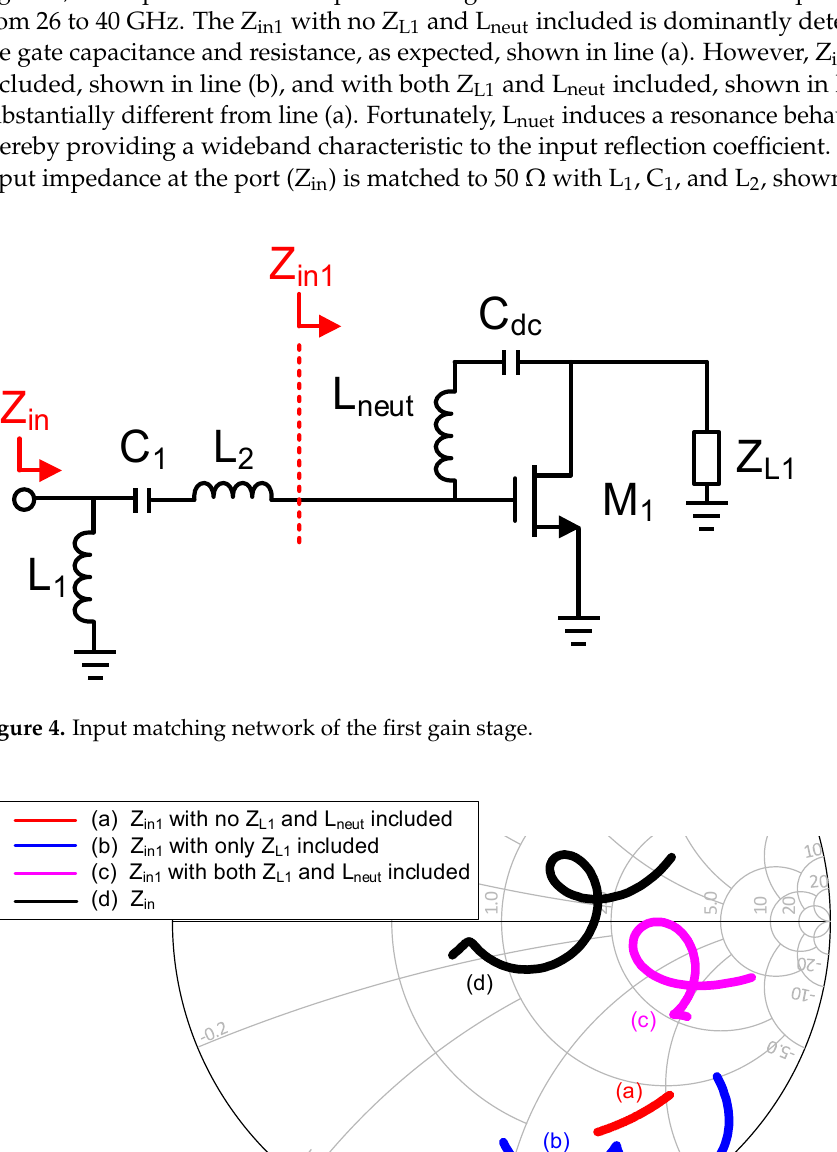
Figure 5. Loci of the input impedances from 26 to 40 GHz.